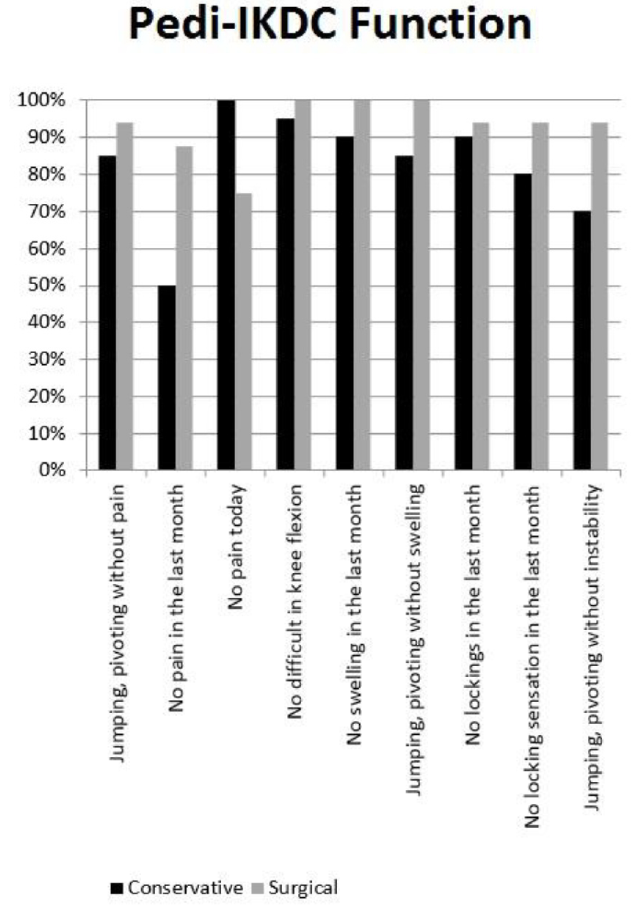
Figure 2. Pedi-IKDC Figure 2. Pedi ‐ IKDC Function.